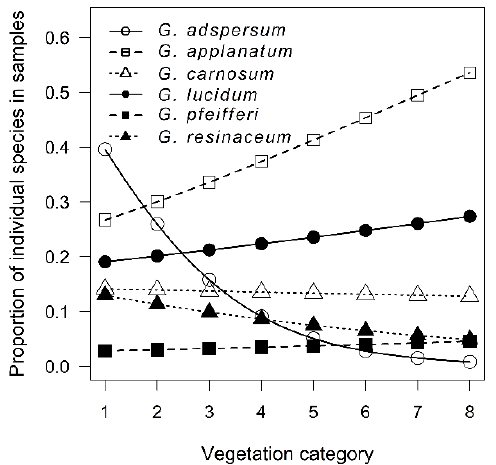
Figure 1. Proportion of individual Ganoderma species along the vegetation category gradient. The positions of points are predicted from the binomial generalized linear mixed model .